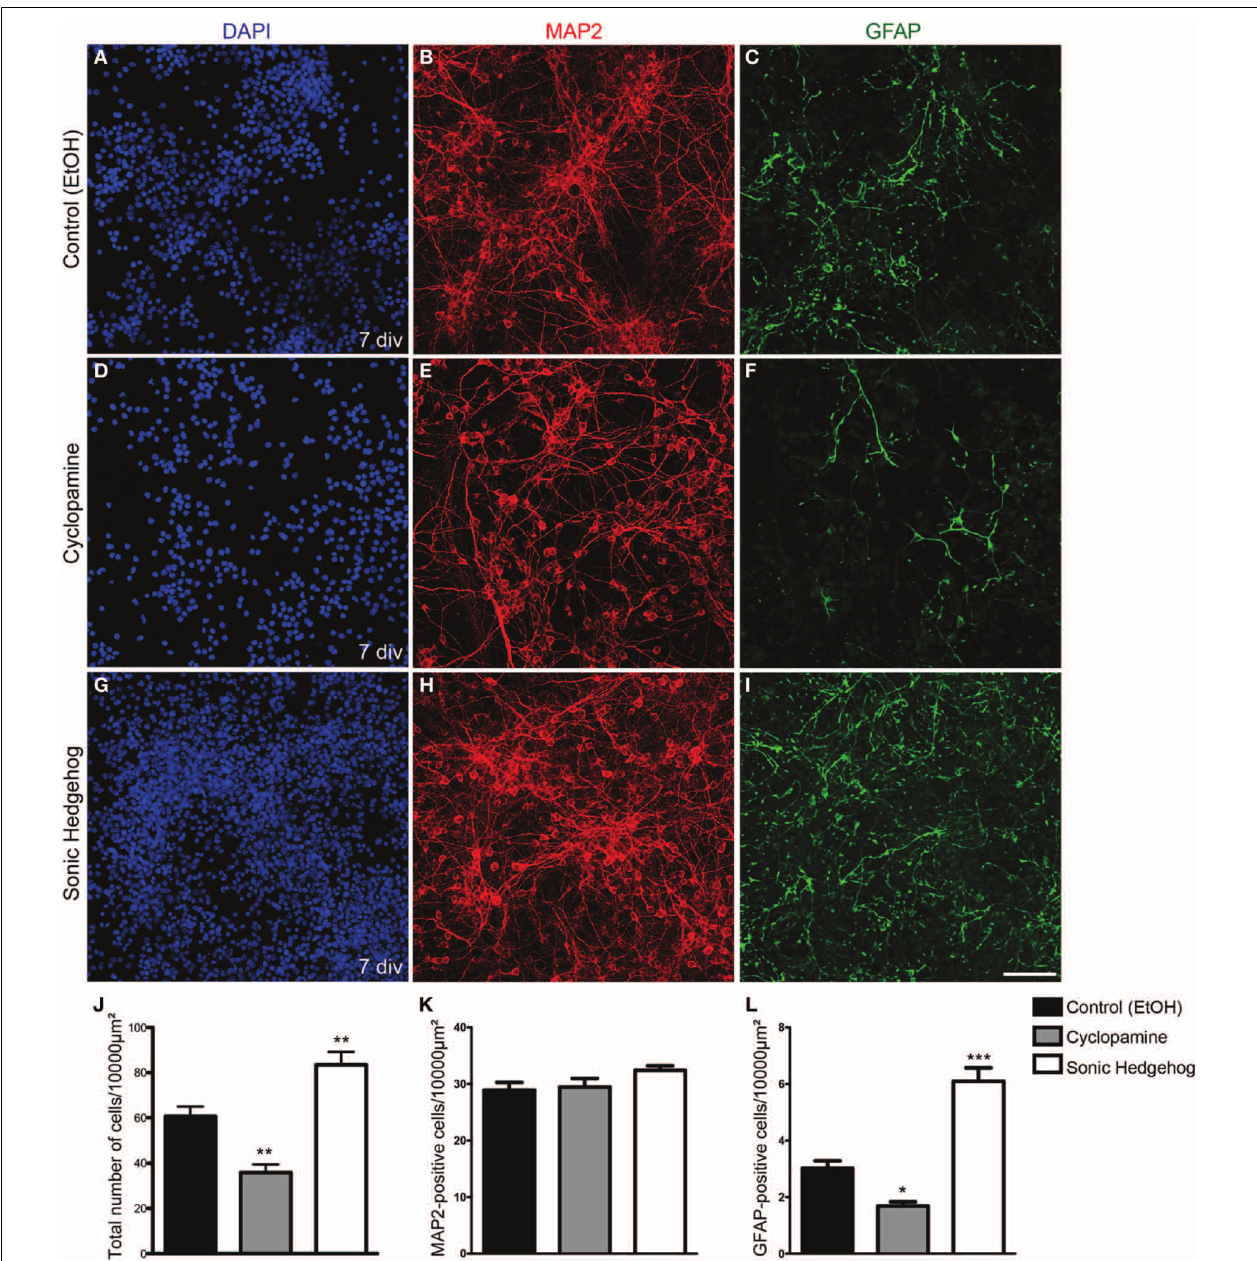
FIGURE 1 | Increased cellularity in cultures treated with SHH. (A–I) Images of E13 cortical cell cultures treated with EtOH (A–C) control, cyclopamine (D–F) , or SHH (G–I) . Cultures were immunolabeled after 7 div using antibodies against GFAP (green) and MAP2 (red) and stained with DAPI (blue). Note the reduction in GFAP-expressing cells in cultures treated with